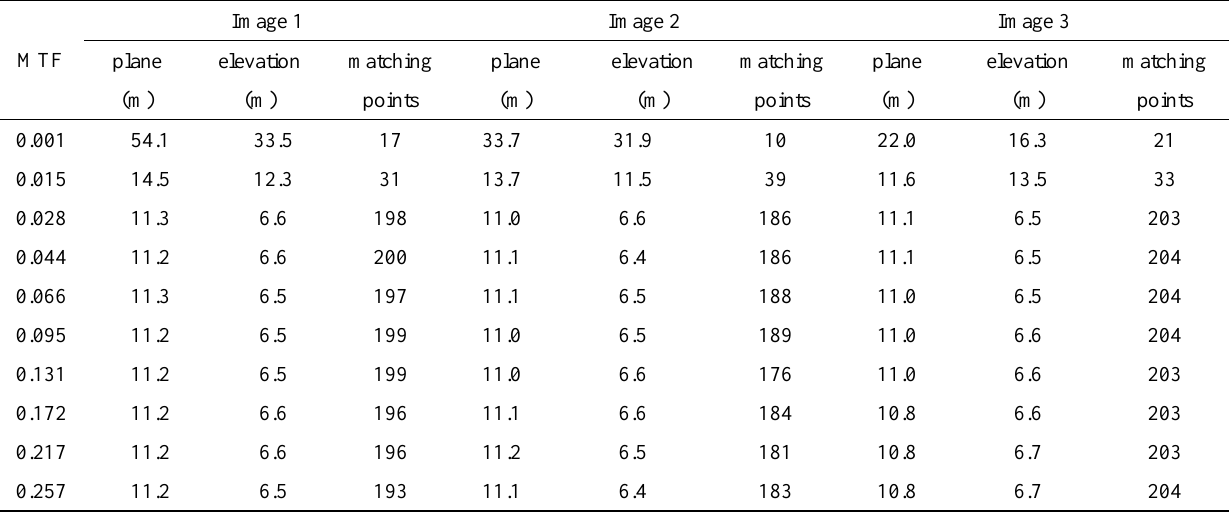
Table 1. The plane error, elevation error and number of matching points with different